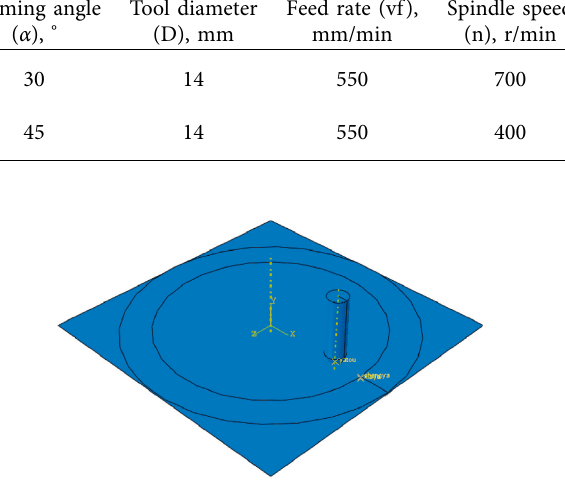
Figure 9: Finite element model of single point incremental forming.